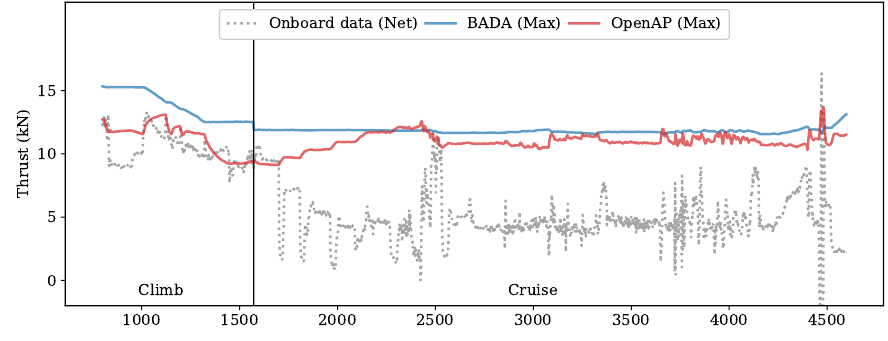
Figure 13. Maximum thrust profile.